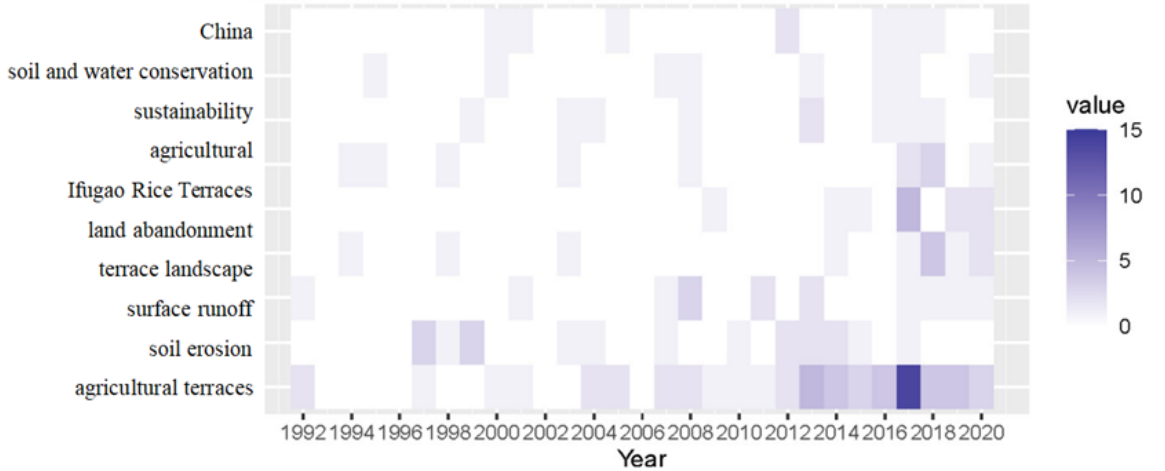
Figure 8. Thermal map of terrace research.